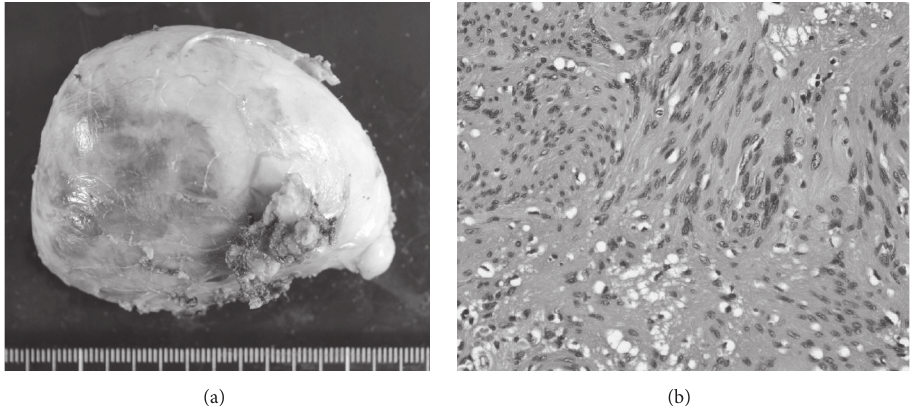
Figure 4: (a) The specimen was a firm, elastic, 70 × 50mm mass with a capsule. (b) Palisade arrangement of spindle-shaped cells (hematoxylin-eosin, ×